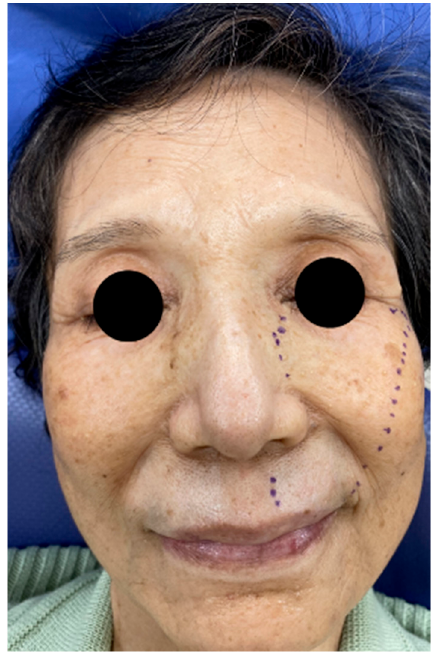
Figure 1. Range of hypoesthesia on the left face of the patient. Simple neurosensory testing results showed decreased perception of a pinprick light touch and temperature at the second branch of the left trigeminal division (V2), including the intraoral area. Cranial motor function and the masseter reflex were intact. The remaining neurosensory status was normal.